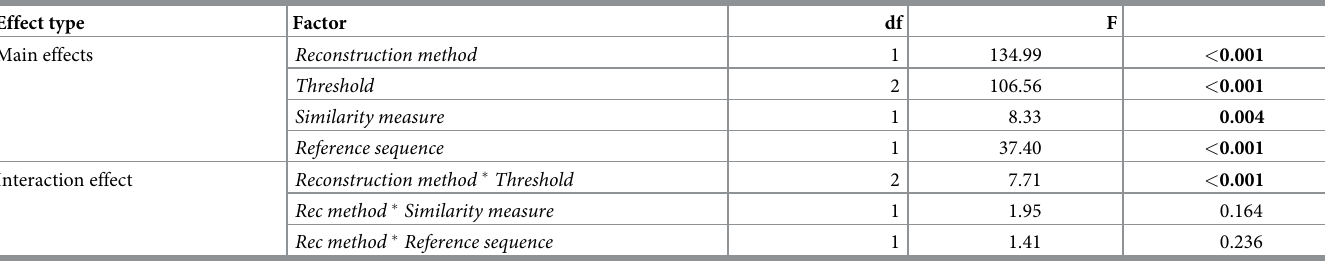
Table 3. Main results of the ANOVA on the reconstruction